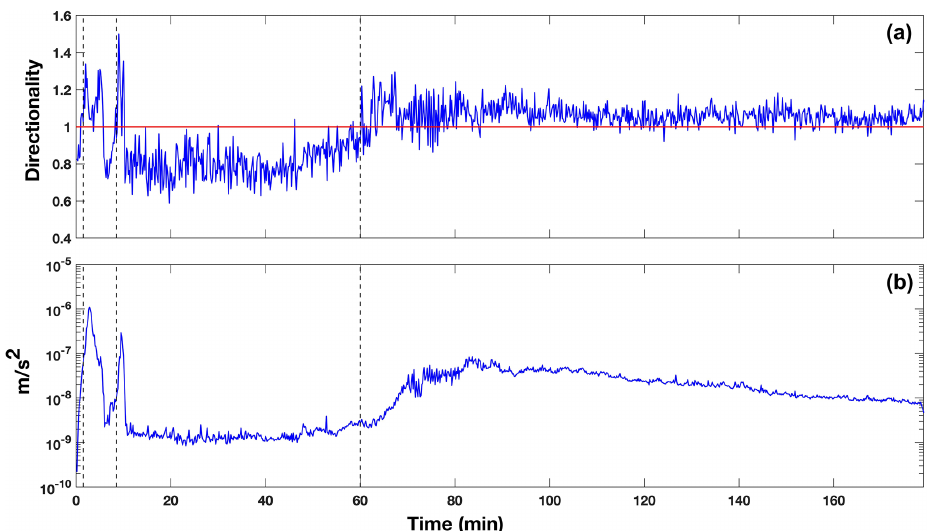
Figure 10. (a) Directionality ratio for the time sequence of the three lahars that occurred on 25 September 2007. (b) Rms amplitude of the seismic record at RTMT during the timing of the three September lahars. Note that the dashed black lines represent the timing of each lahar arriving at the monitoring